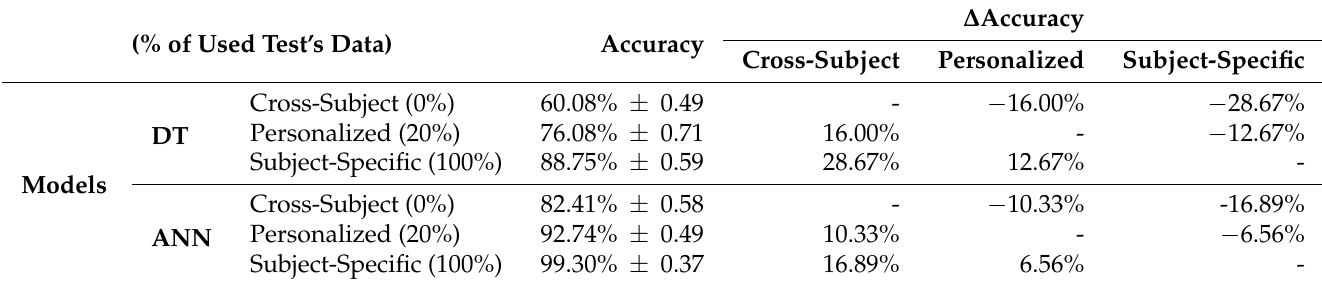
Table 6. Percent accuracy achieved on, with a CI of 95%, the cross-subject, subject-specific, and personalization